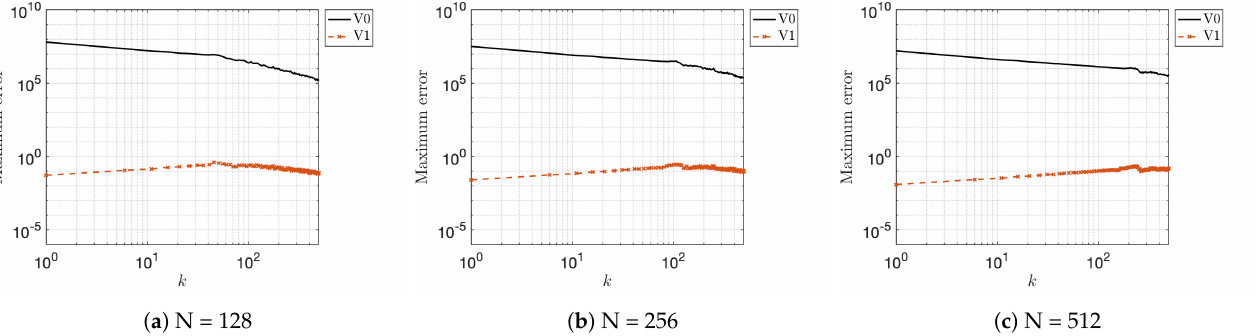
Figure 11. Helmholtz 2D. Log-Log of the maximum error in computing the solution of Problem (18) as described in Section 4.2.1, with respect to the wavenumber k , for various number of quadrature points N .